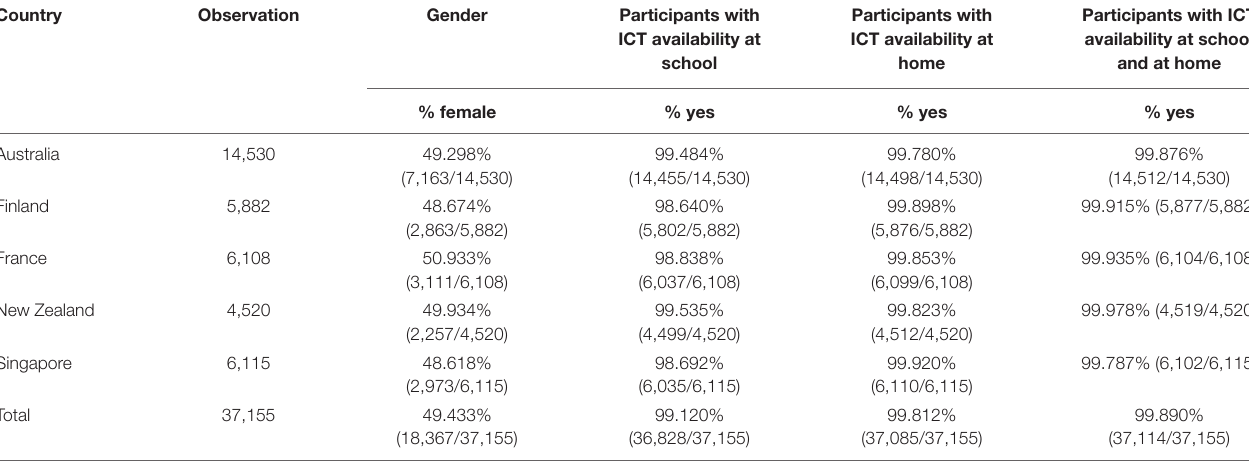
TABLE 1 | Demographic information of participants from five representative countries. Country